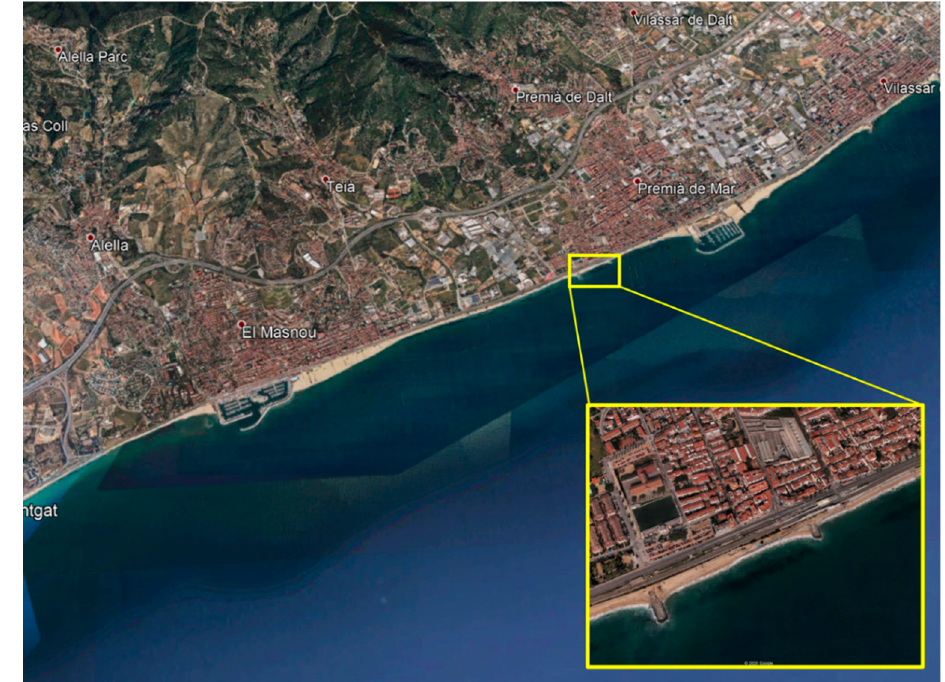
Figure 2. Territorial framework of the study case (source: Google Maps).